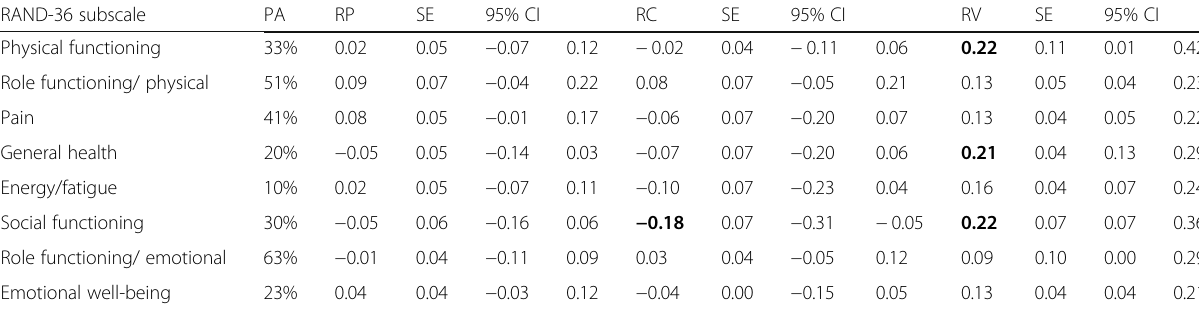
Table 7 Test-retest analysis using Svensson ’ s method for ordinal paired data for the dialysis patients RAND-36 subscale PA